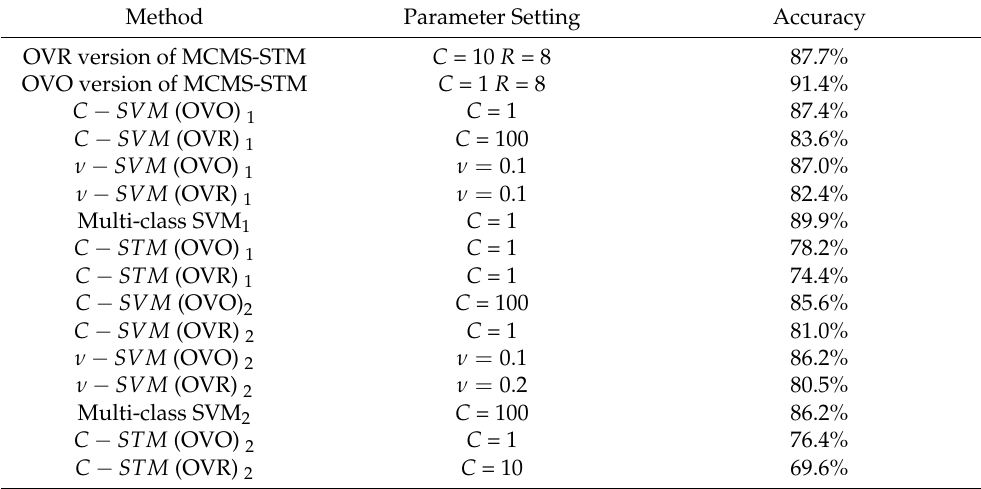
Table 6. The accuracies of different methods for multiscale ships recognization using 10-fold cross-